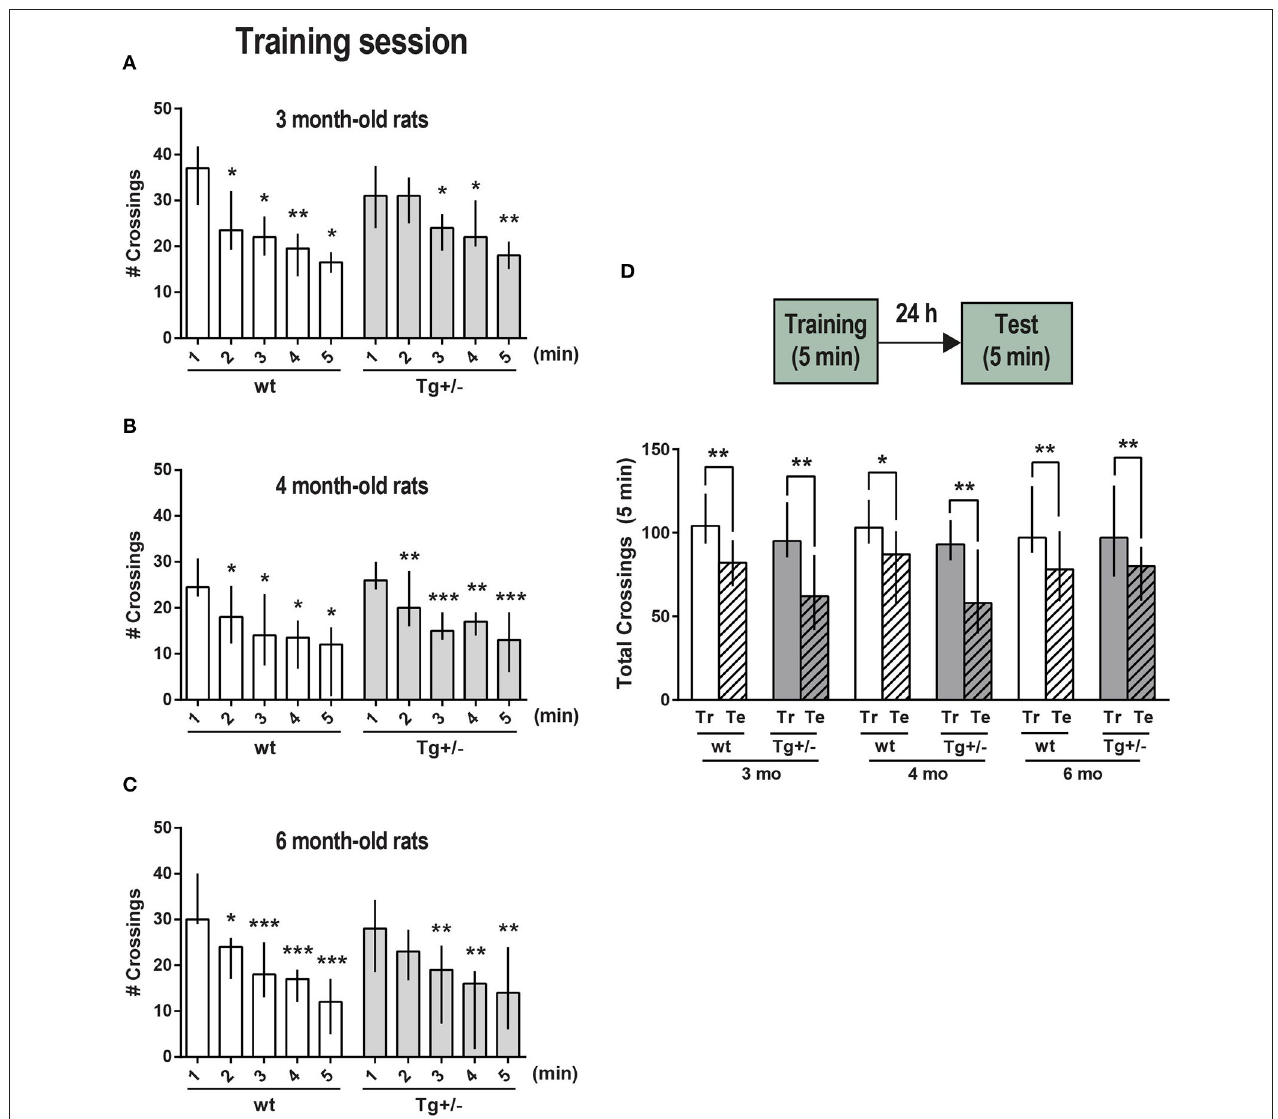
FIGURE 1 | Exploration and habituation to an OF. McGill-R-Thy1-APP Tg + /– male rats (dark gray bars) and their wt littermates (white bars) were trained and tested for short-term (ST, intra-session) habituation to an OF at (A) 3, (B) 4, and (C) 6-months of age. Bar diagram shows median and interquartile ranges (25;75) for the number of crossings recorded during each minute of a 5min session (training, Tr). Significant differences were assessed by Wilcoxon matched pairs signed rank test; * P < 0.05, ** P < 0.01, *** P < 0.001 (3 mo: N wt = 8, N Tg + / − = 11; 4 mo: N wt = 8, N Tg + / − = 11; 6 mo: N wt = 11, N Tg + / − = 10). (D) Long-term (LT) habituation to an OF (LTM). Bar diagram shows median and interquartile ranges (25;75) for the total number of crossings recorded during a 5min training session (Tr, plain bars) and during the test session (Te, stripped bars) which was performed 24h later (schematic representation of the task steps on top). No significant differences were observed between any selected pair of training sessions amongst the wt or Tg + /– animals (Unmatched Kruskal-Wallis test with Dunn’s multiple comparisons). Total crossings during test session were significantly lower than during training session for the three different ages, either for wt or Tg animals. Statistically significant differences were assessed by Wilcoxon matched pairs signed rank test; * P < 0.05, ** P < 0.01 (3 mo: N wt = 8, N Tg + / − = 8; 4 mo: N wt = 8, N Tg + / − = 9; 6 mo: N wt = 11, N Tg + / − =